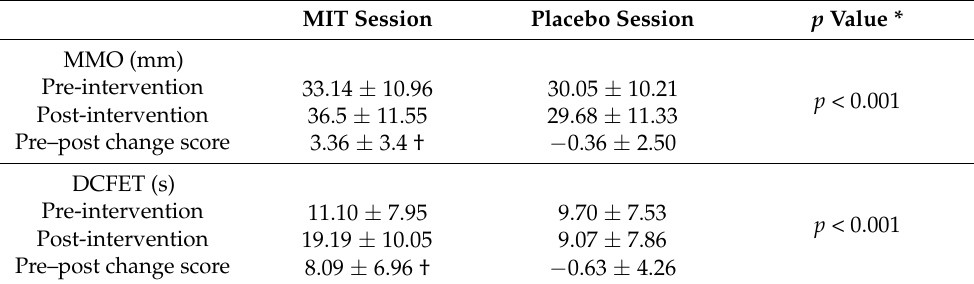
Table 5. Pre-intervention, post-intervention, and change scores for MMO and DCFET ( n =